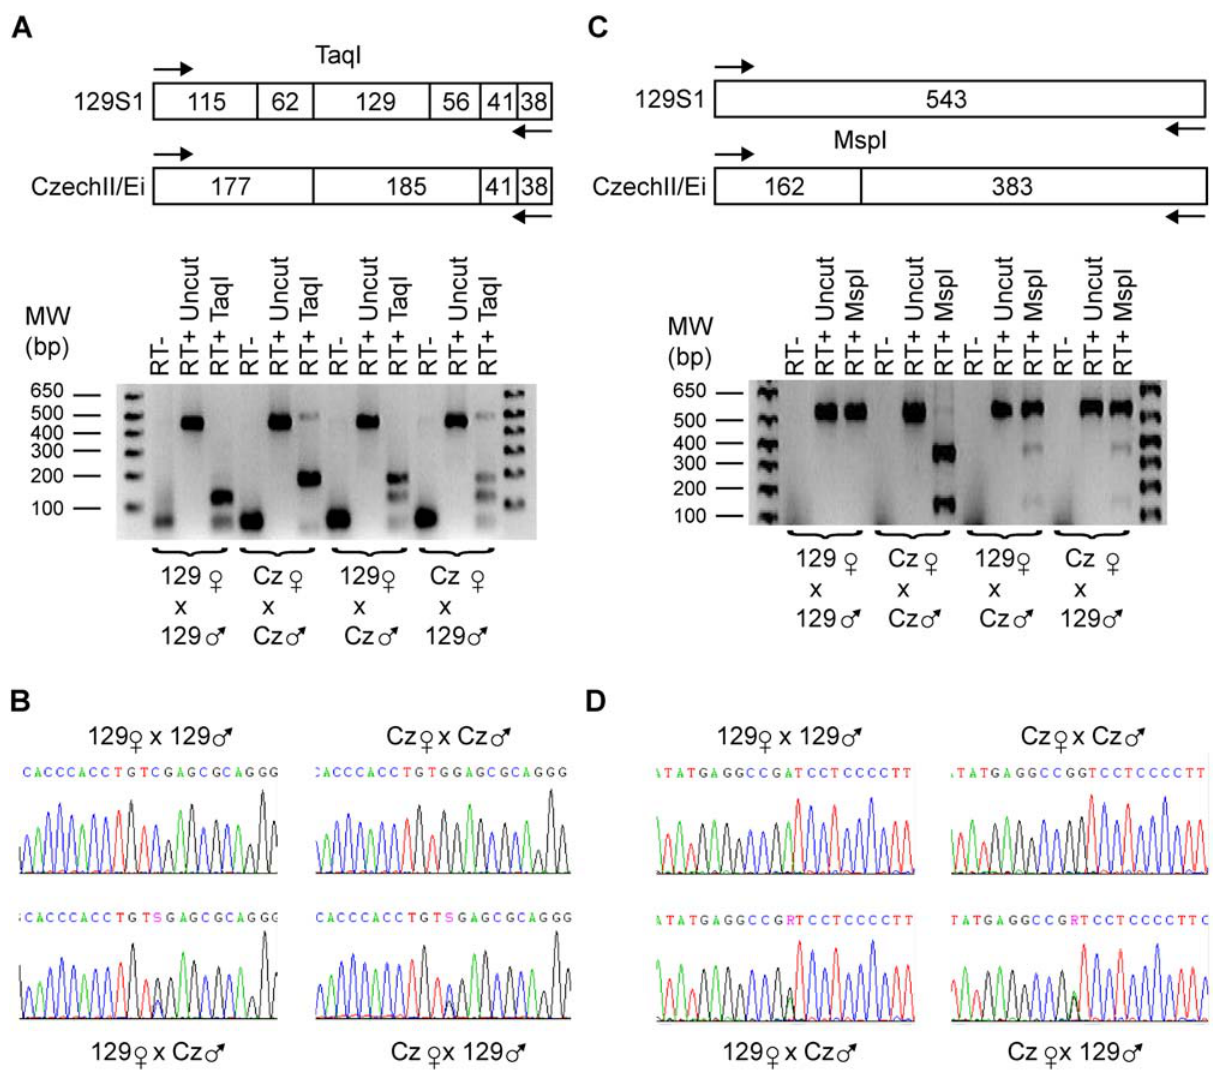
Figure 11. Allelic Expression of Dio3 and Anti-Dio3 (A) Dio3 is an atypical imprinted gene in that the expression occurs preferentially from the paternal allele. Expression of the maternal allele occurs at roughly one-quarter the level of its paternal counterpart as evidenced by TaqI digests and (B) direct sequencing of RT-PCR products using Dio3 1216Up/1657Dn primers. (C) Anti-Dio3 is biallelically expressed as evidenced by MspI restriction digests and (D) direct sequencing of RT-PCR products using Dio3-AS 654Up/1197Dn